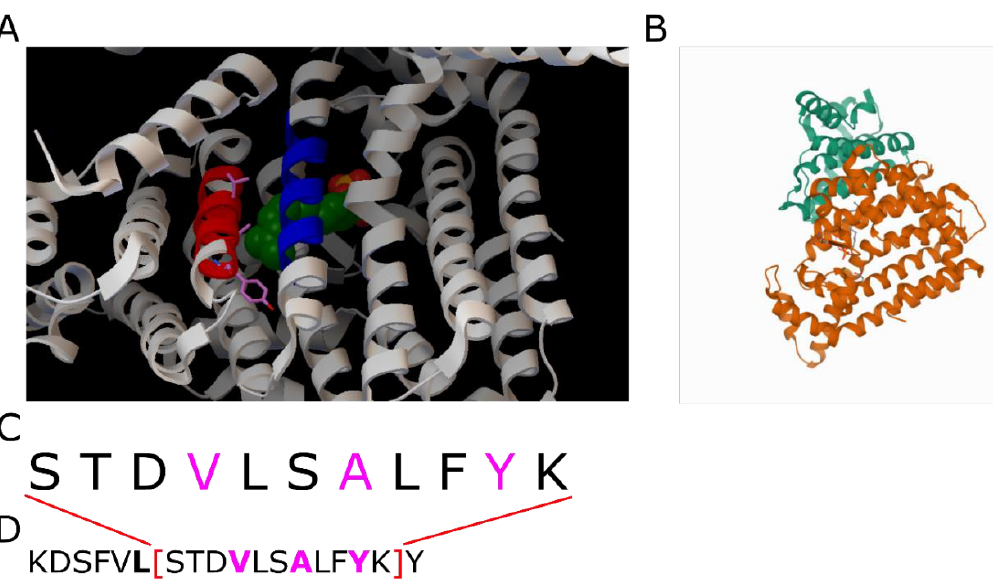
Figure 5. PDB-ID 3aqc, the ligand-bound form of 3aqb. ( A ): Detailed view on the coiled coil. The red α -helix realizes the demanding [4, 3, 3]-decomposition. The blue α -helix is the interaction partner for the formation of the coiled coil. ( B ) Shows a total view on the protein with different colors for its subunits. ( C ): Amino acid sequence of the coiled-coil range analyzed by the CCdb. ( D ): Complete sequence of the α -helix. Contact residues of the coiled coil are bold. The contact residues of the [3, 3]-repeat are colored in magenta, corresponding to ( A ).